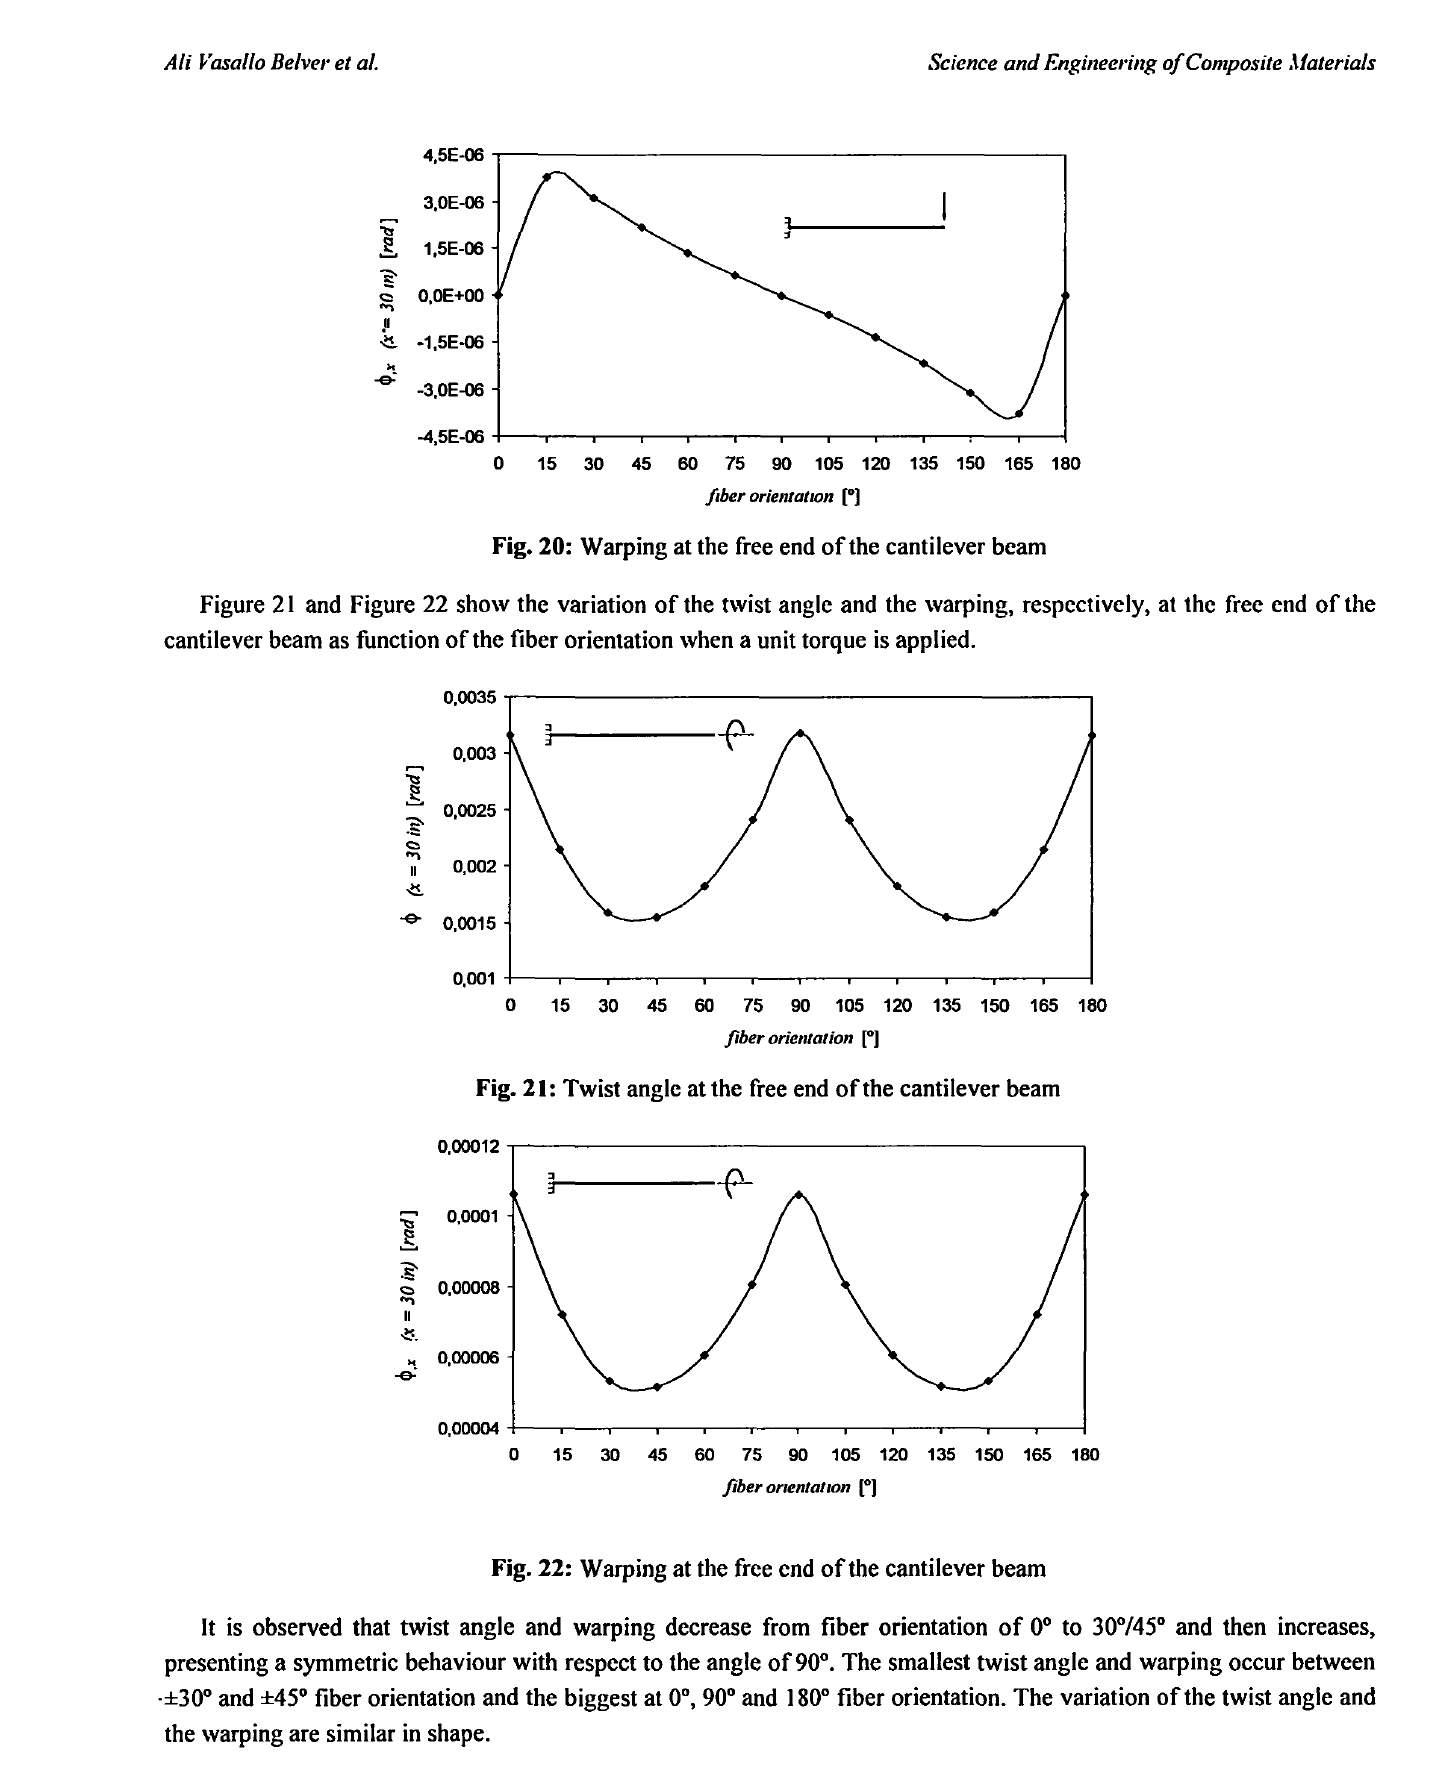
Fig. 22: Warping at the free end of the cantilever